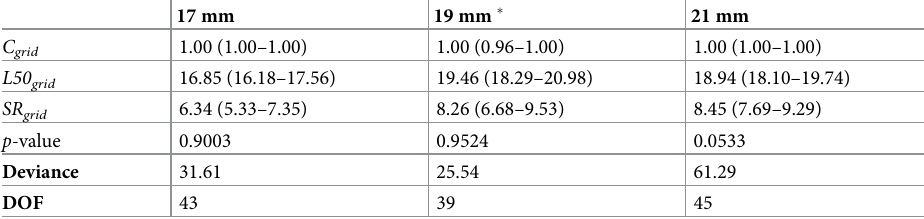
Table 4. Selectivity parameters and fit statistics for American plaice describing the grid passage probability for the three different grids considered in this study. 17 mm 19 mm � C